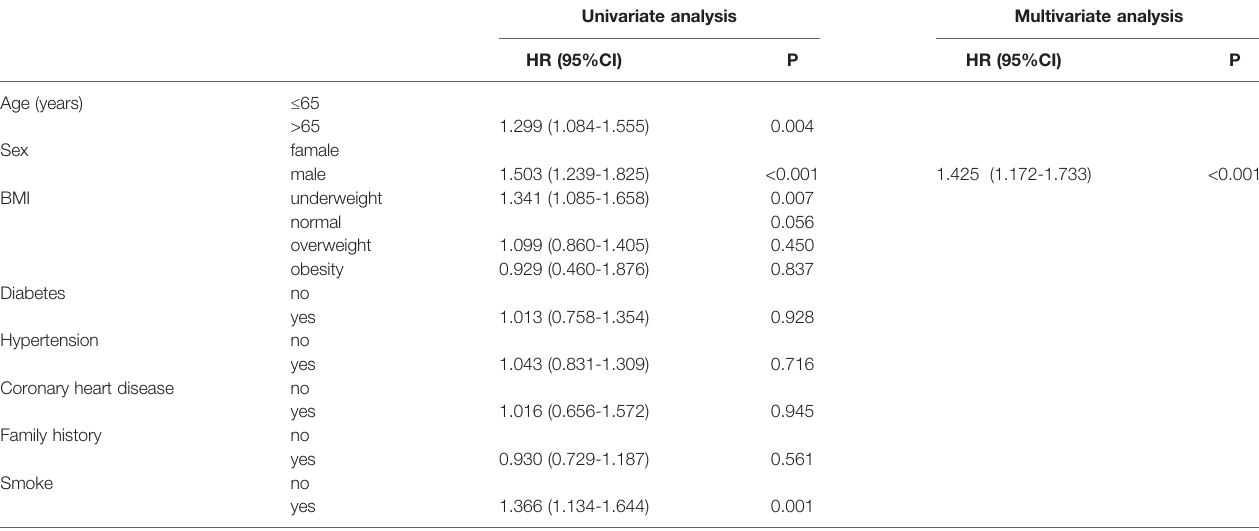
FIGURE 4 | The ROC curve (A) , calibration curve (B) , and decision curve analysis (C) of the diagnostic nomogram in validation set. TABLE 3 | Cox regression analysis of lung cancer patients with